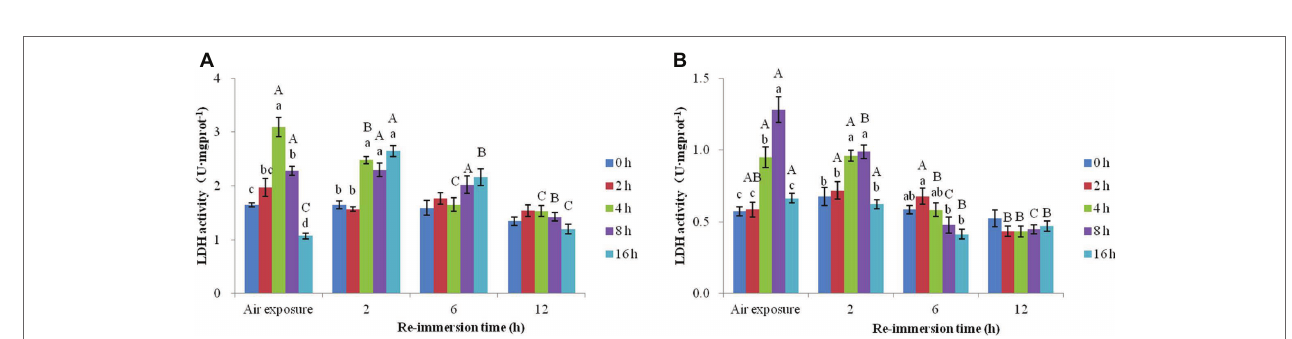
FIGURE 3 | Effects of air exposure and reimmersion on lactate dehydrogenase (LDH) in the gills (A) and hepatopancreas (B) of Chinese mitten crab. Different lowercase letters represent a significant difference between the different air exposure times at the same reimmersion time ( p < 0.05). Different uppercase letters represent a significant difference between the different reimmersion times at the same air exposure time ( p <